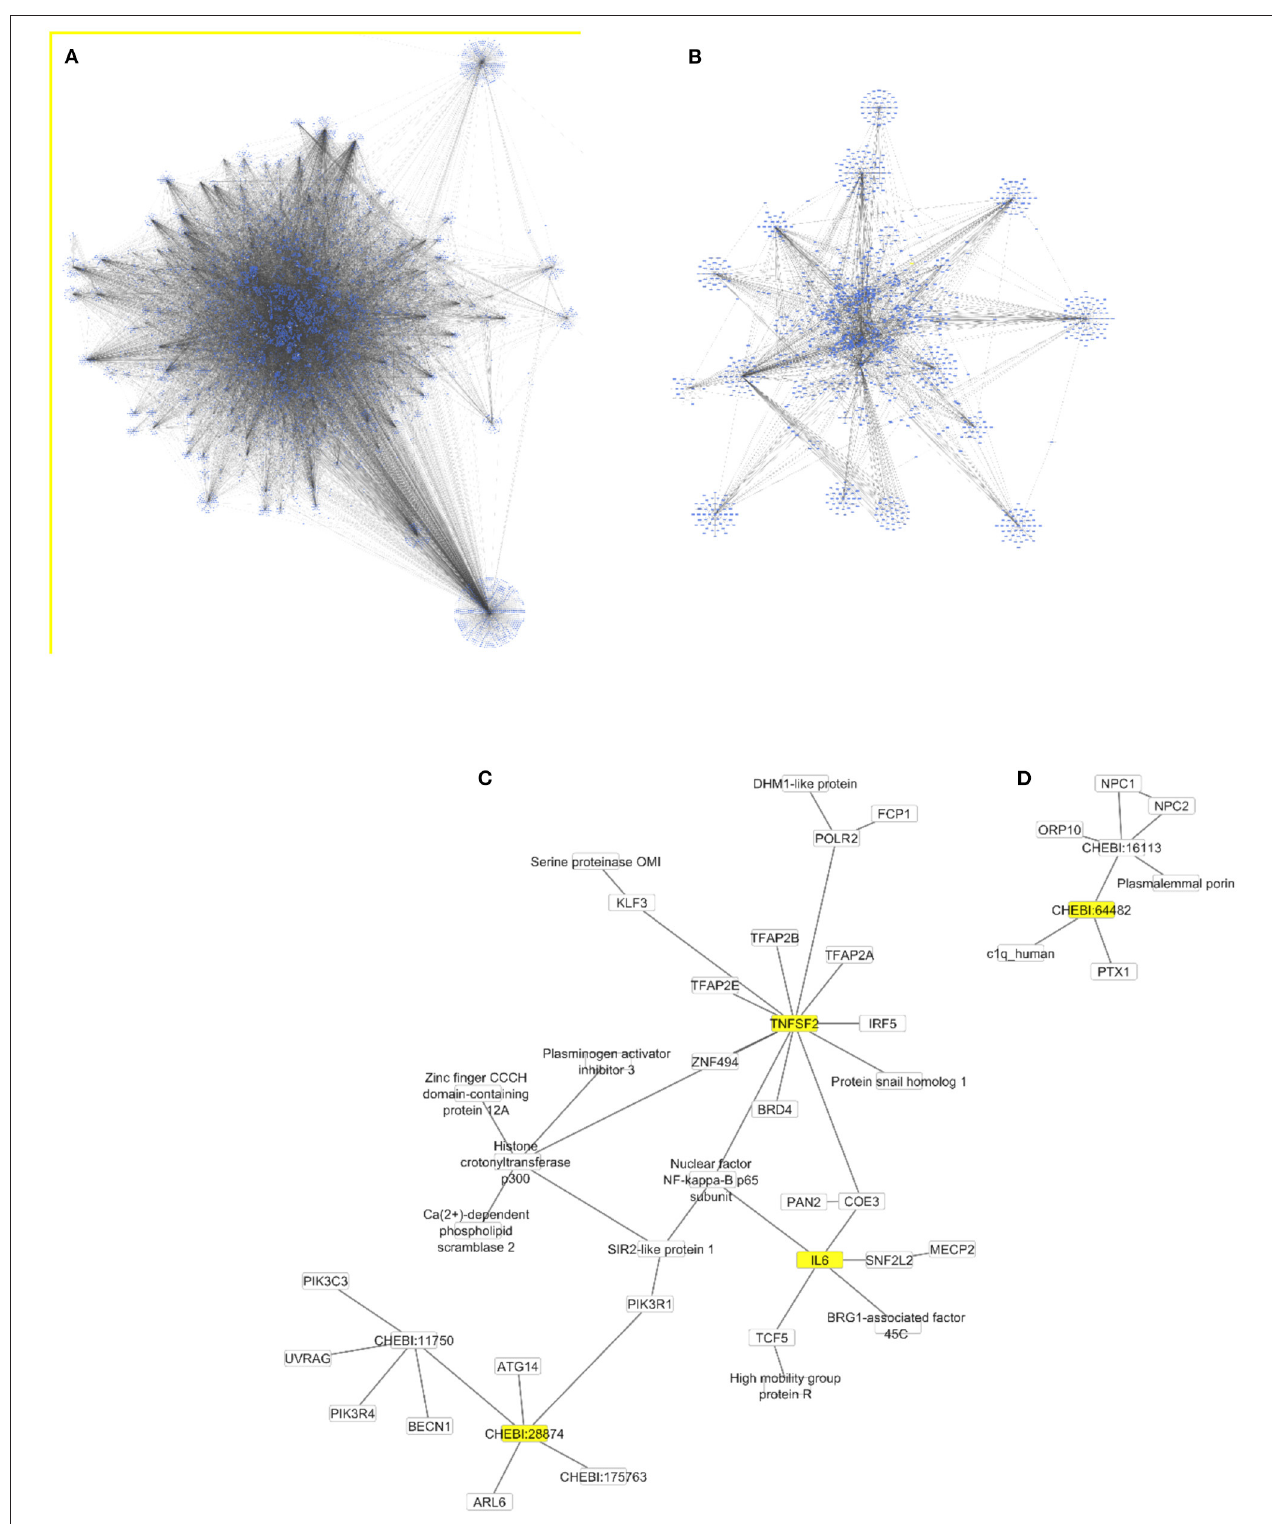
FIGURE 9 | Protein-lipid networks linked to the proinflammatory cytokines [IL6 and TNF- α (TNFSF2)] as complete (A) , using the first directed (B) and undirected (C,D) neighbors to phosphatidylinositol (CHEBI:28874) and phosphatidylcholine (CHEBI:64482) as nodes colored in yellow. All networks are displayed using the yFiles organic